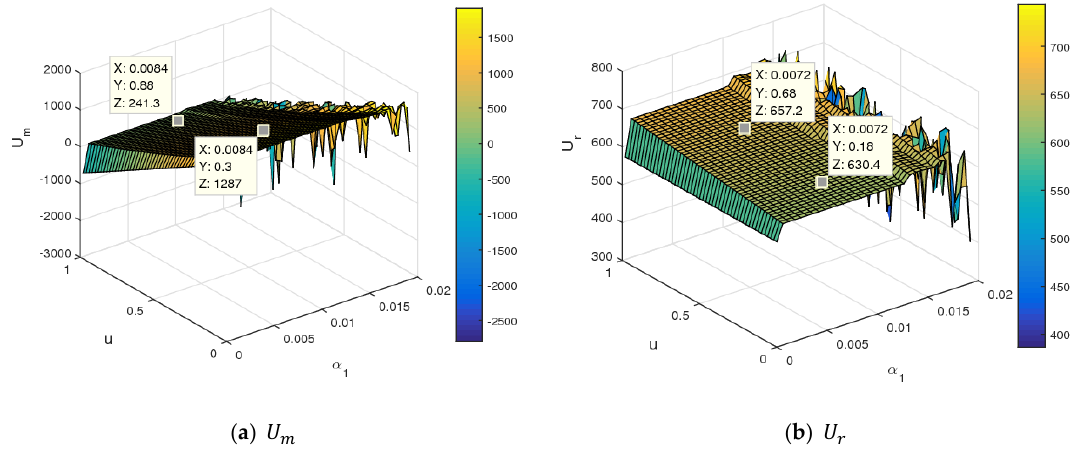
Figure 17. The utility changes of the manufacturer and retailer with respect to 𝛼 1 and 𝑠.